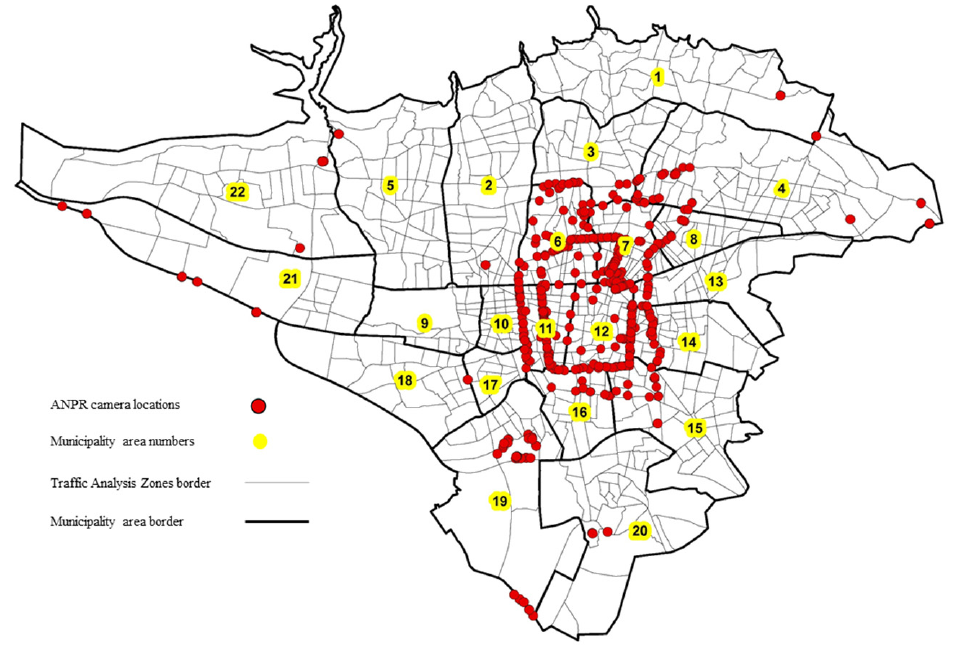
Figure 2. Location of ANPR cameras.